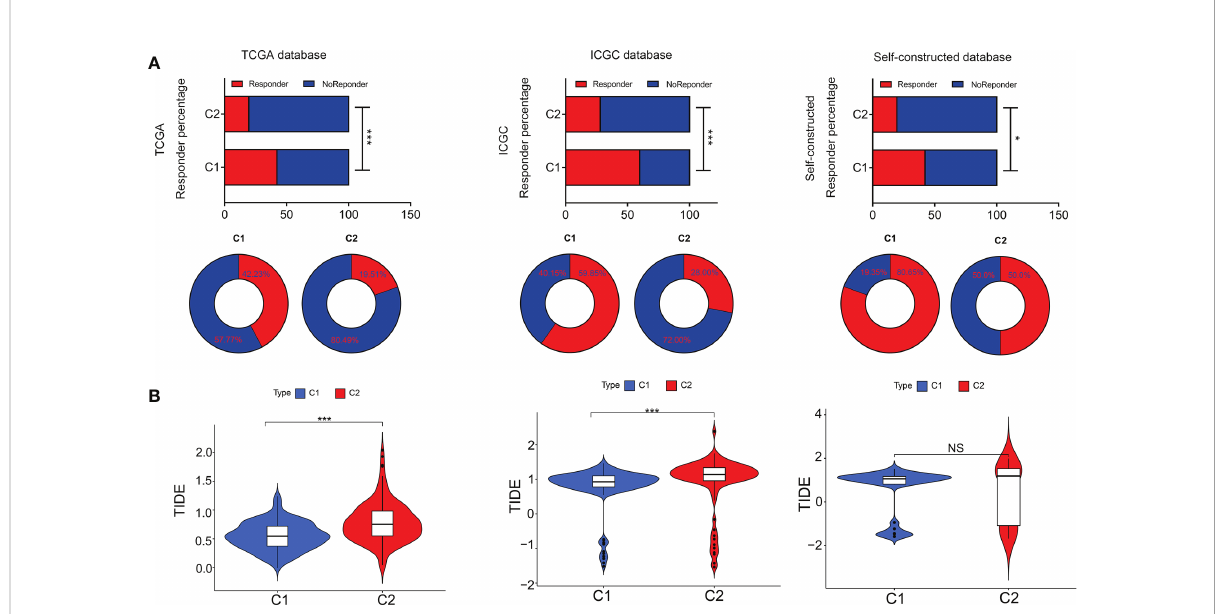
FIGURE 7 Tumor immune dysfunction & exclusion in both subtypes. (A) Responder percentage in Tumor immune dysfunction and exclusion analysis based on TCGA, ICGC and self-constructed database. (B) Tumor immune dysfunction and exclusion value between C1 and C2. *P<0.05, ***P<0.001. NS: Not Signi fi